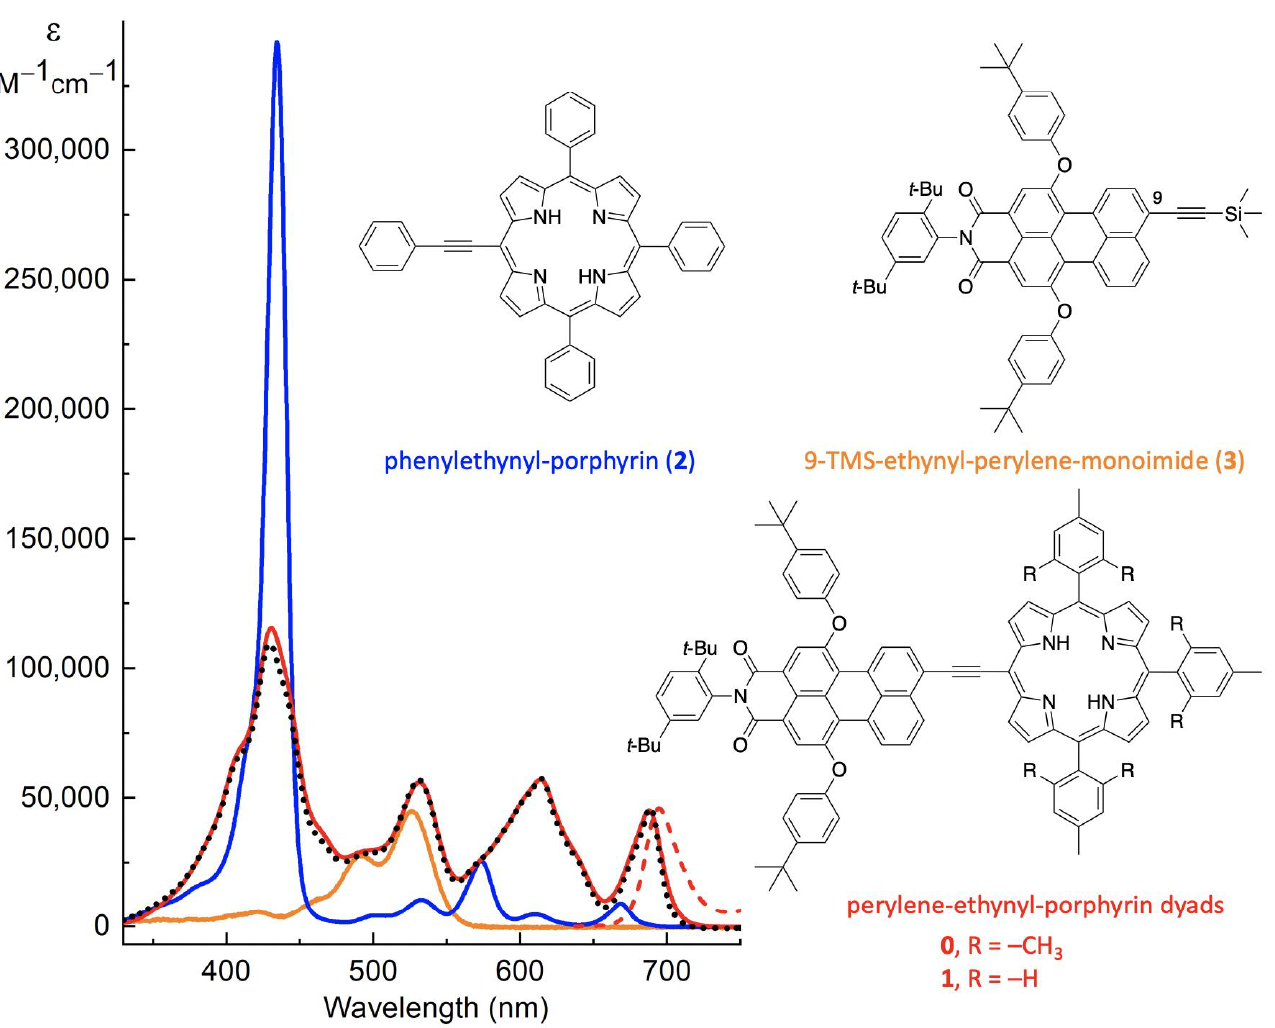
Figure 1. Absorption spectra of a perylene-ethynyl-porphyrin dyad ( 1 , solid red line), to be compared with phenylethynyl-porphyrin ( 2 , solid blue line) and perylene-ethyne ( 3 , solid orange line) constituents (in toluene at room temperature). The fluorescence spectrum of 1 also is shown (dashed red line; λ em 695 nm) [42]. The absorption spectrum of the perylene-ethynyl-porphyrin dyad 0 (dotted black trace [41]) is essentially identical with that of analogous dyad 1 (solid red line).